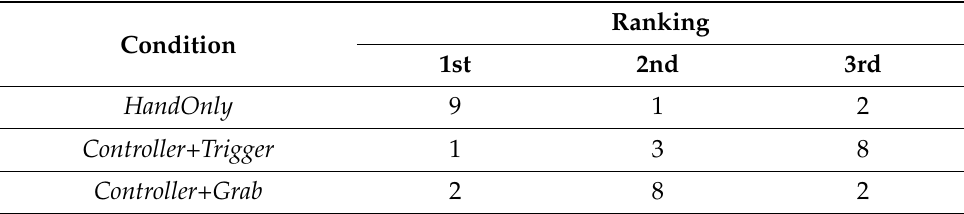
Table 6. The number of mentions when asking the participants to rank the interaction methods as having the most potential, the second and the least